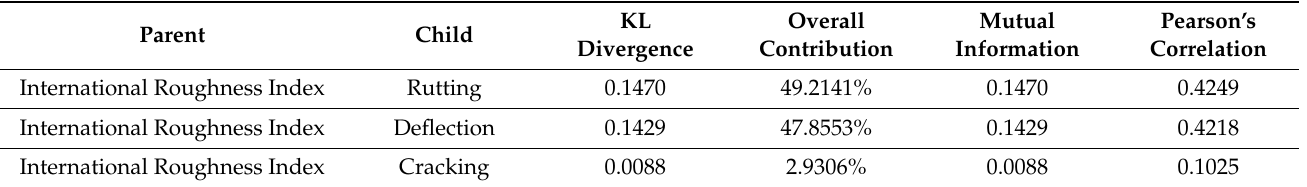
Table 5. Relationship analysis among road distress parameters.